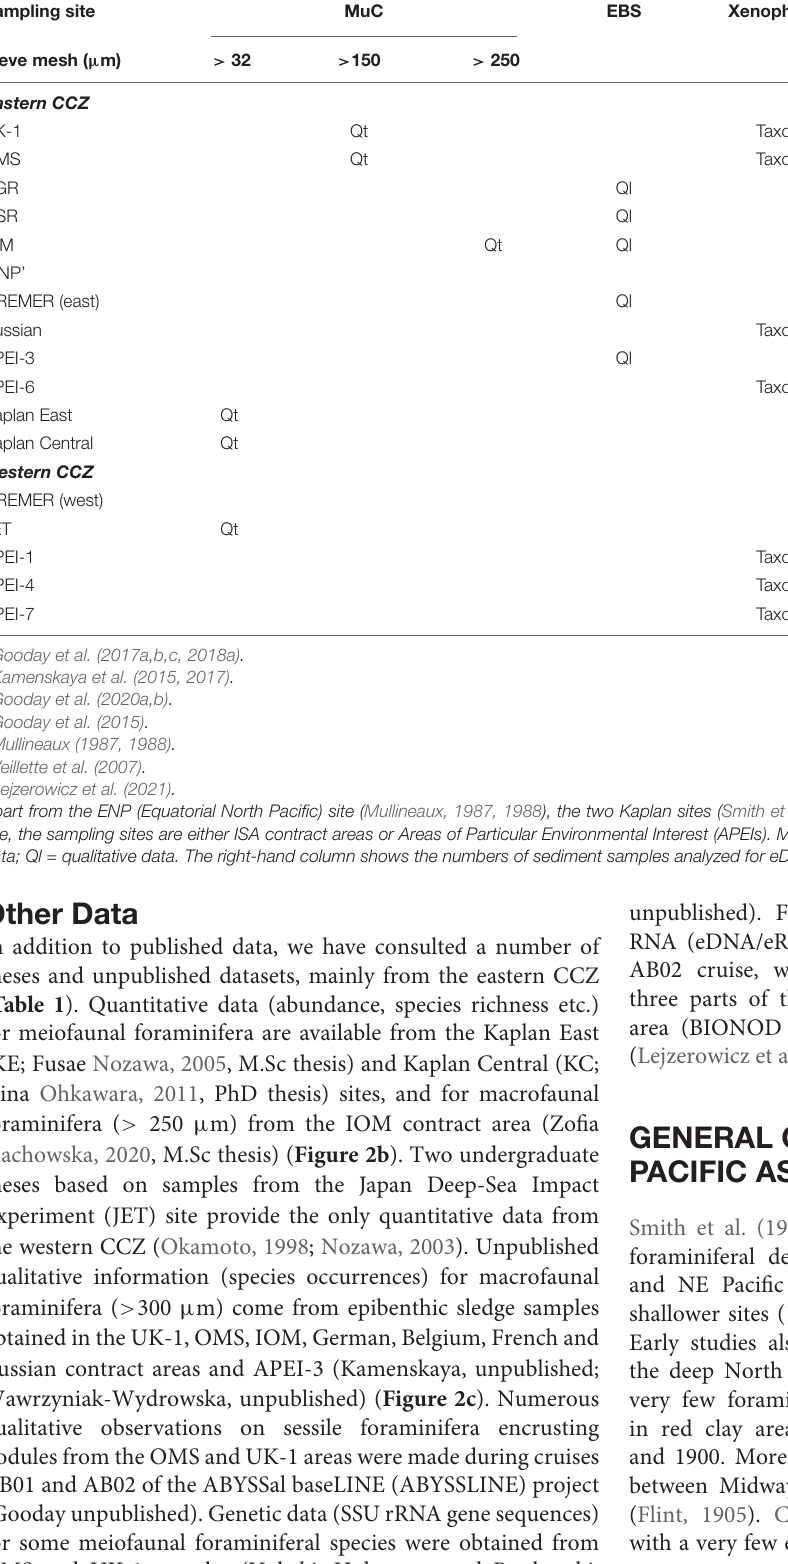
TABLE 1 | Distribution of samples from the CCZ used for published and unpublished foraminiferal studies. Sampling site MuC EBS Xenophyophores Nodule fauna